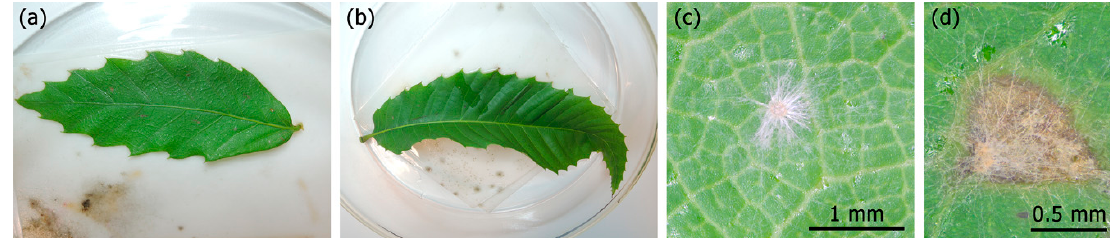
Figure 6. Pathogenicity test on Castanea sativa : ( a ) Control on the 21st day; ( b ) inoculated leaf on the 21st day; ( c ) germination of a propagule on the 2nd day; ( d ) necrotic leaf spot on the 21st day.